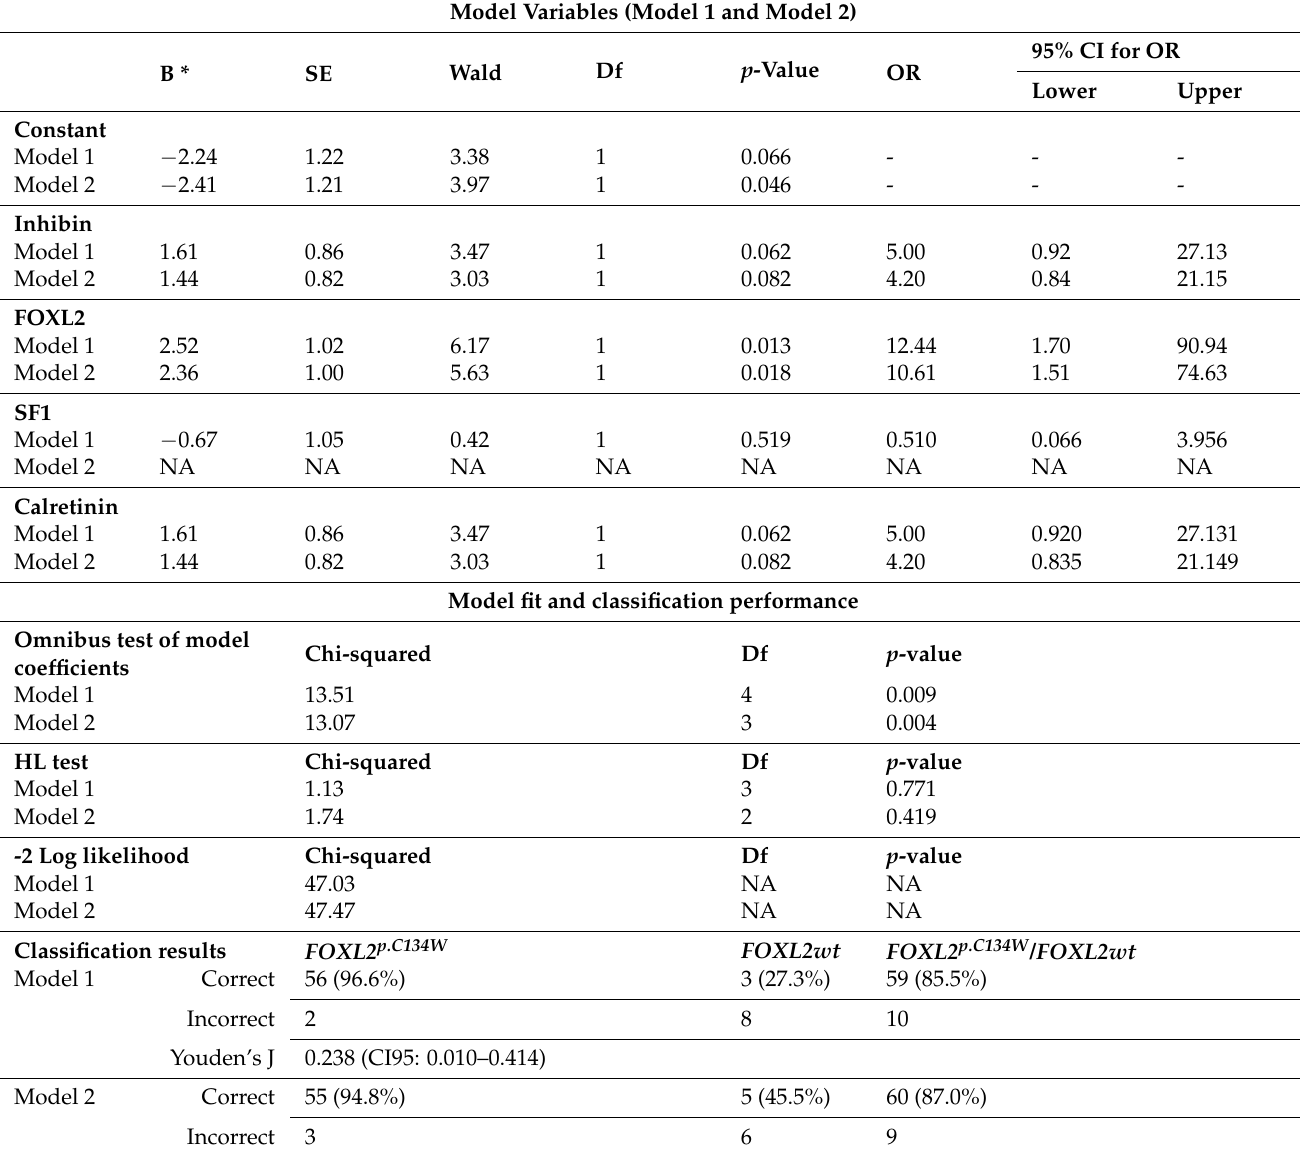
Table 3. Logistic regression analysis of association between FOXL2 mutational status and four IHC